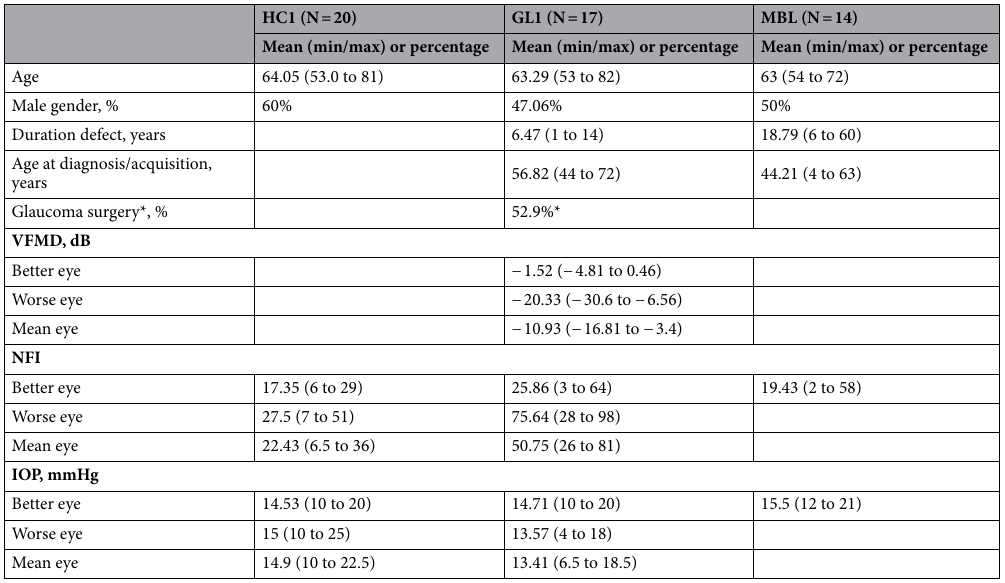
Table 1. Characteristics of Cohort 1 (collection site at Netherlands; NL). VFMD = mean deviation (dB), NFI = nerve fiber indicator, IOP = intraocular pressure. *Either Baerveldt shunt, cataract extraction or